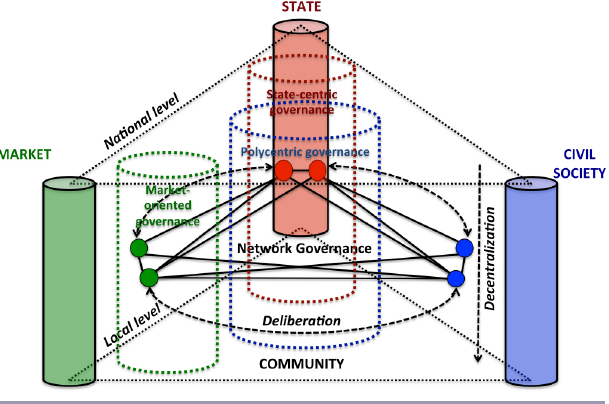
Fig. 1. Conceptual framework of modes and processes of forest governance. The three main sectors are state, market, and civil society, and the models of governance are state-centric, market- oriented, polycentric, and network. These occur across scales from the national to the community level, along with the paired processes of decentralization and deliberation. Nodes and solid lines represent network governance; dashed arrows represent the processes of decentralization and